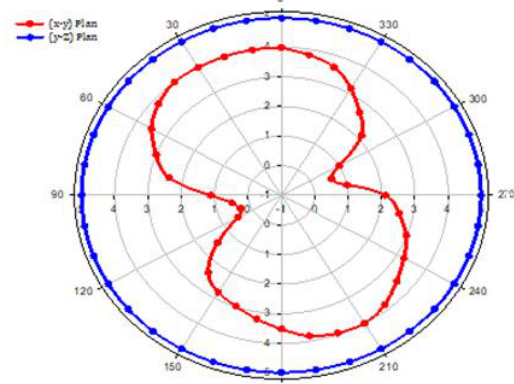
Figure 12: Measured read range patterns of the proposed RFID